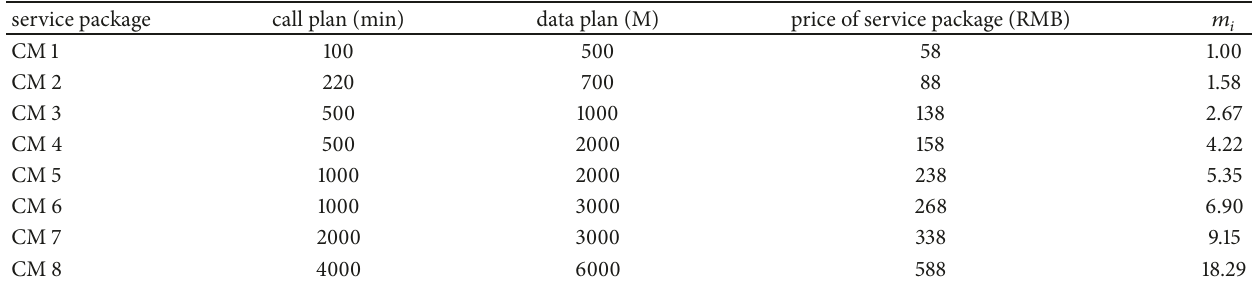
Table 1: The price list of CMCC.